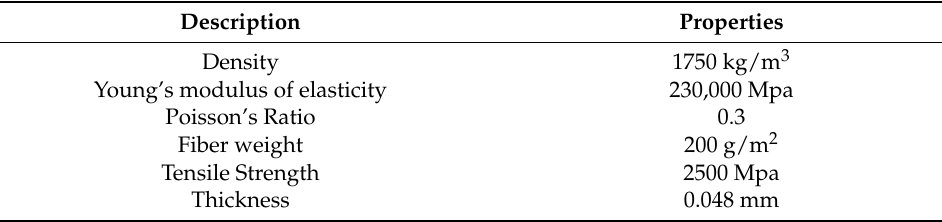
Table 3. Carbon fiber mesh properties.